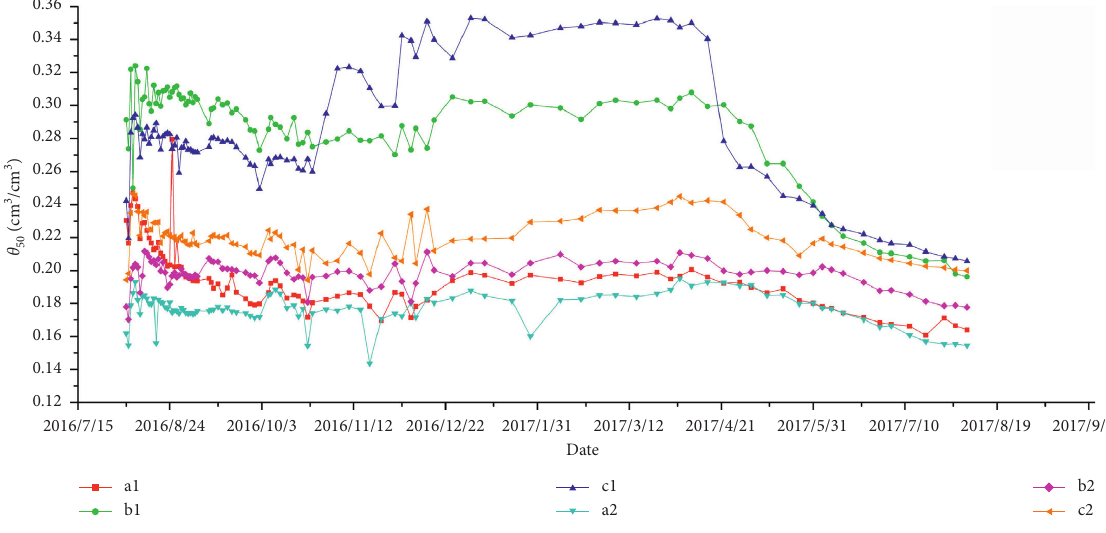
Figure 12: Curves of the average water content of 50 cm thick soil varying with